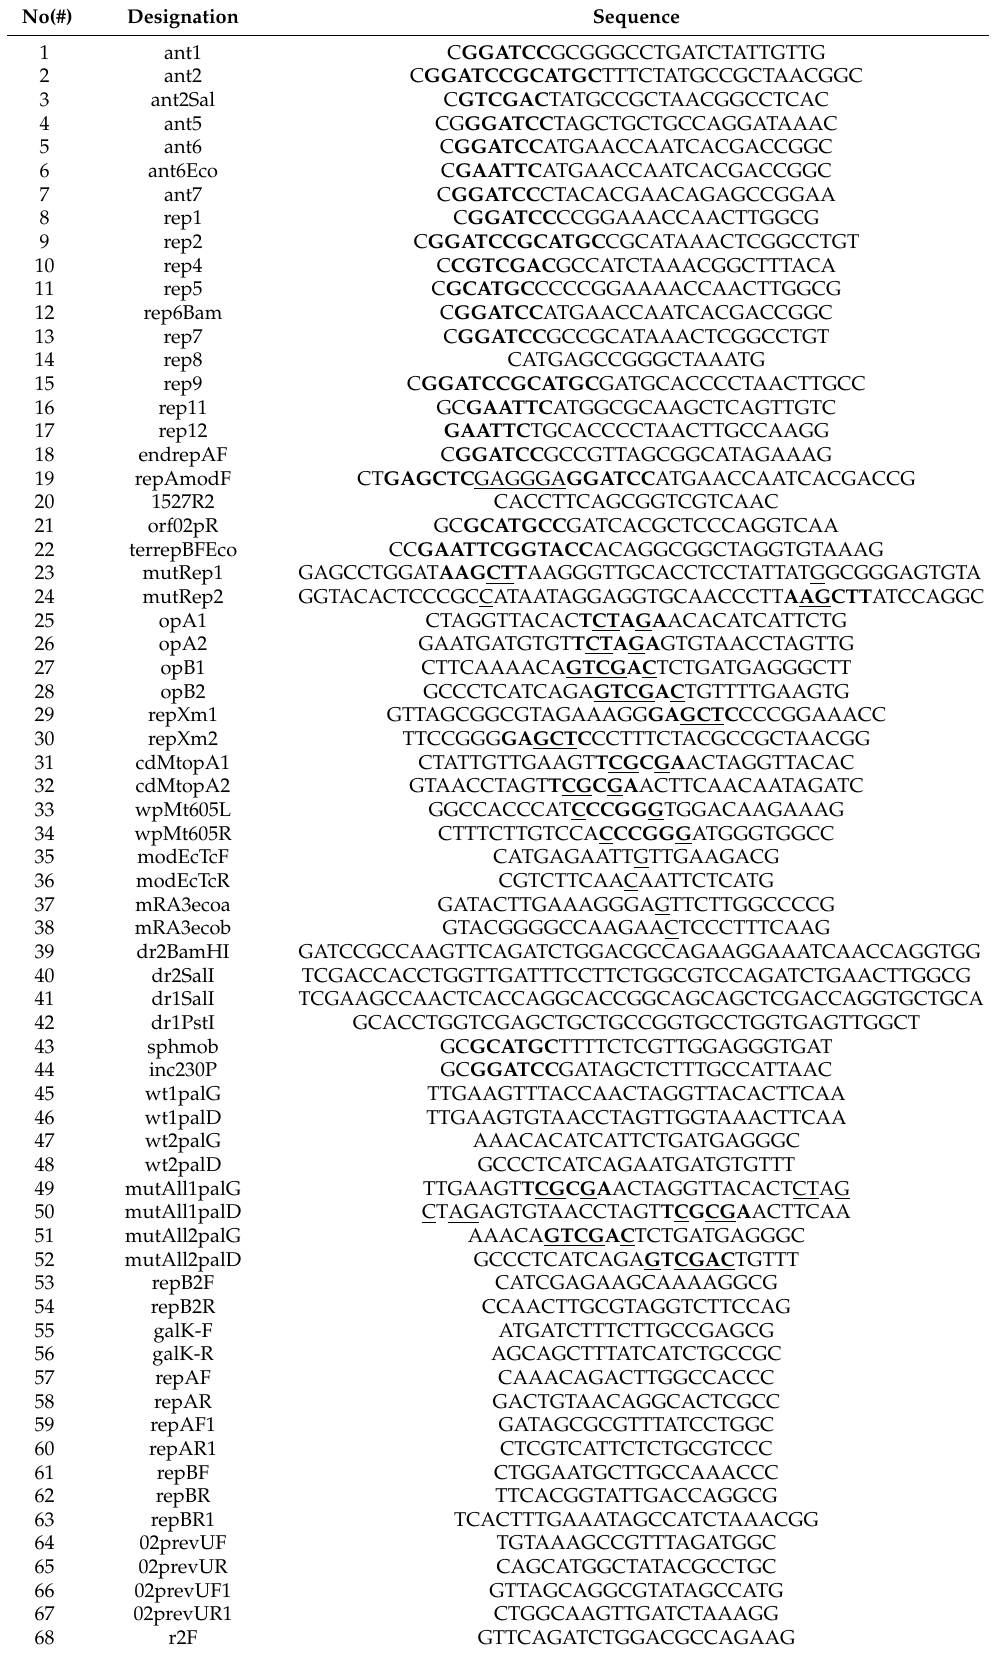
Table 3. List of primers used in this